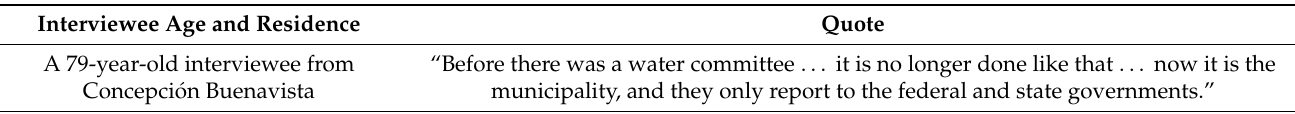
Table 5. Local knowledge of institutional changes in the management of the water system for domestic use with implications in five communities of the Mixteca Alta region in Oaxaca,